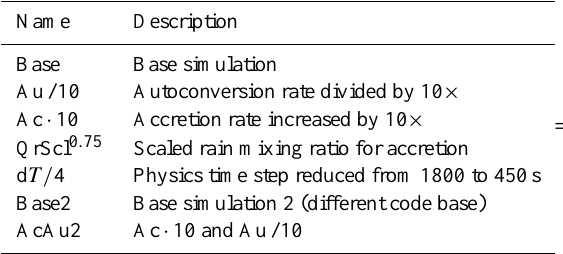
Table 2. Description of global simulations used in this